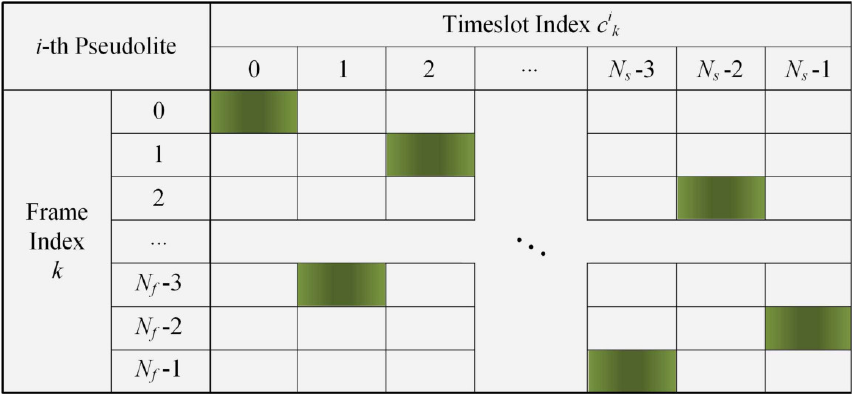
Figure 2. Illustration of the pulse